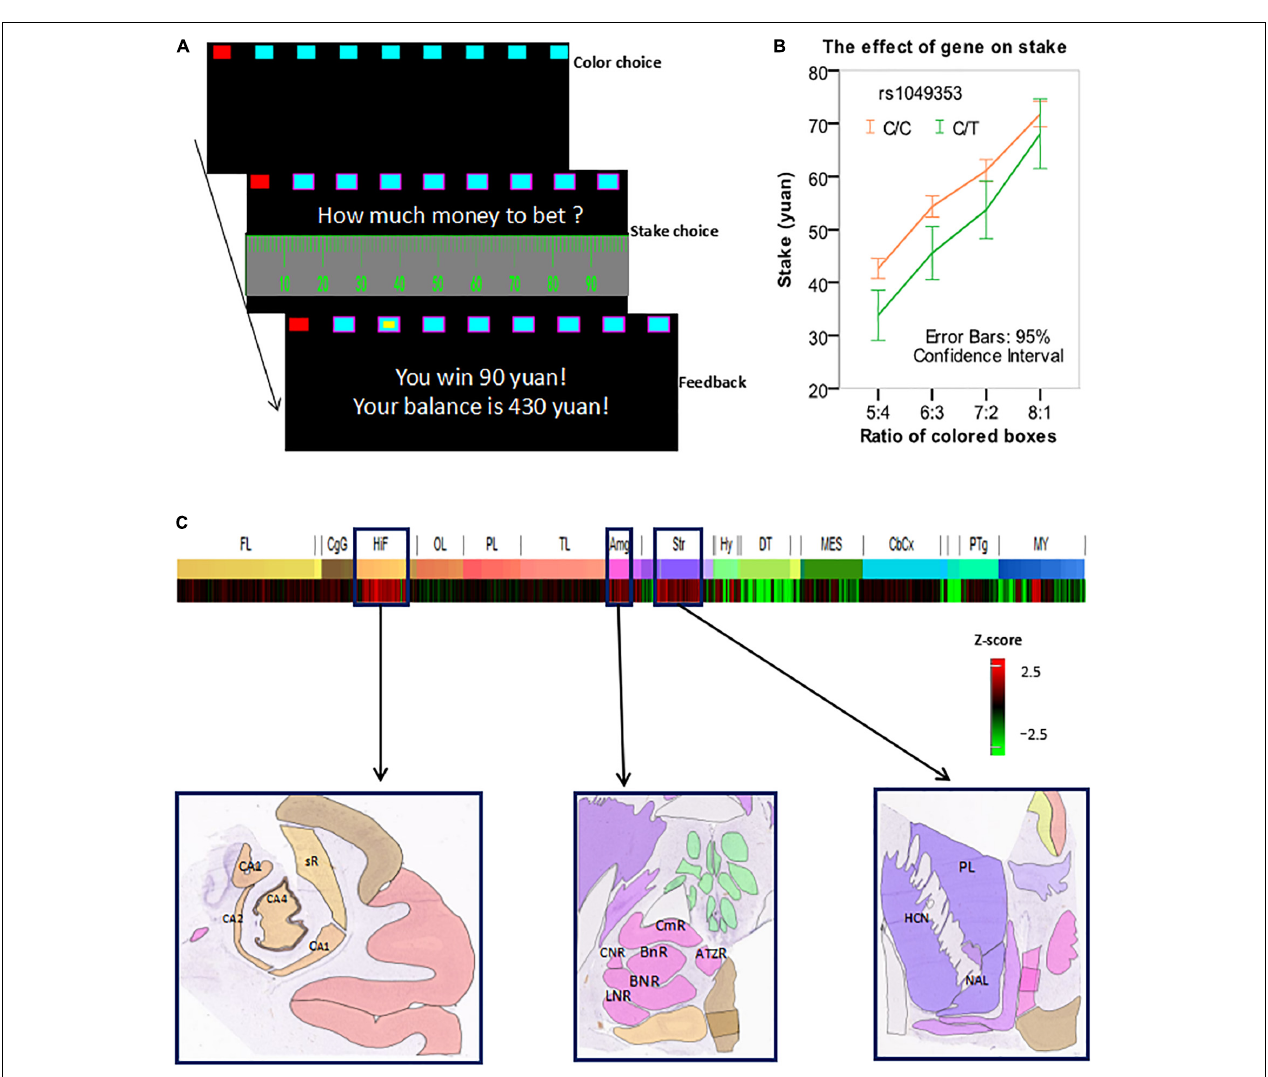
FIGURE 1 | (A) An exemplar trial of the modified Cambridge gambling task (MCGT). (B) Stake was influenced by both box ratio and genotype. (C ) The CNR1 gene was overexpressed in the hippocampus, amygdala, and striatum. Z-score bar: Higher redness represents a higher expression level of the CNR1 gene in a brain region. HIF, hippocampal formation; CA1, CA1 field, right; CA2, CA2 field, right; CA4, CA4 field, right; sR, subiculum, right. AMG, amygdala; CmR, cortico-medial group, right; BnR, basomedial nucleus, right; BNR, basolateral nucleus, right; LNR, lateral nucleus, right; CNR, central nucleus, right. Str, striatum. HCN, head of caudate nucleus, left; PL, putamen, left; NAL, nucleus accumbens, left. Image credit for sub-figures in (C) : Allen